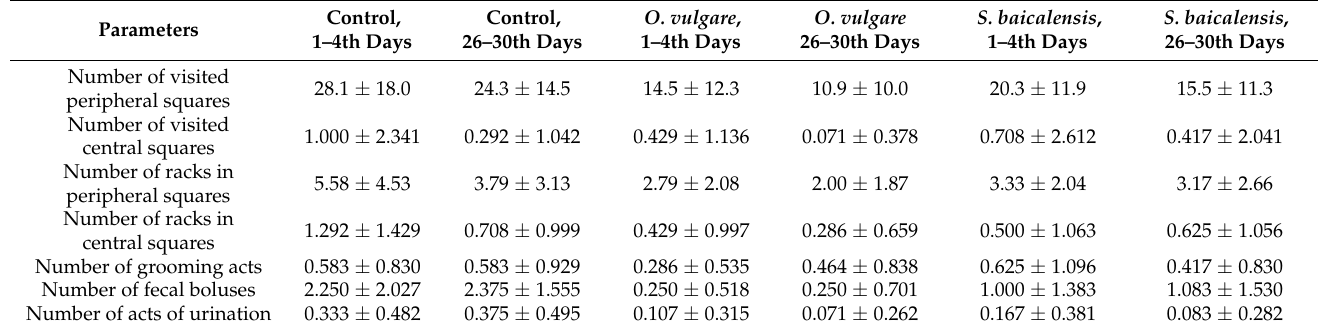
Figure 2. Changes in the levels of physical ( a ) and orientation activity ( b ) and the emotional status ( c ) of male rats when the crushed shoots of Origanum vulgare L. and roots of Scutellaria baicalensis Georgi were added to their diet. On the abscissa axis ( n = n 1 × n 2 = 32: n 1 = 8 animals, n 2 = 4 experiments with each animal) are the groups of animal which were on a high-fat diet with the addition of the ground shoots of plants (the days after the start of the experiment are in parentheses: 1–4th or 26–30th days). Along the ordinate axis is the absolute number of markers of the following types of behavior over 120 s of the experiment: for the physical activity—the number of visited squares in the “open field”; for the orientation activity—the number of racks; and for the emotional status—the number of grooming, defecation and urination actions. A small square is the median, and the upper and lower borders of the rectangle are 75% and 25% of the quartile, respectively. The vertical line denotes the minimum and maximum values, and the circles are outliers. Different letters within each figure indicate significant ( p < 0.05) differences between groups according to the Tukey’s test results. Table 7. Changes of the behavioral characteristics of the three groups of rats during 2 min of the experiment, whose diet was supplemented with Origanum vulgare L. and Scutellaria baicalensis Georgi (x ± SD, n = 32, duration of the experiment was 30 days).